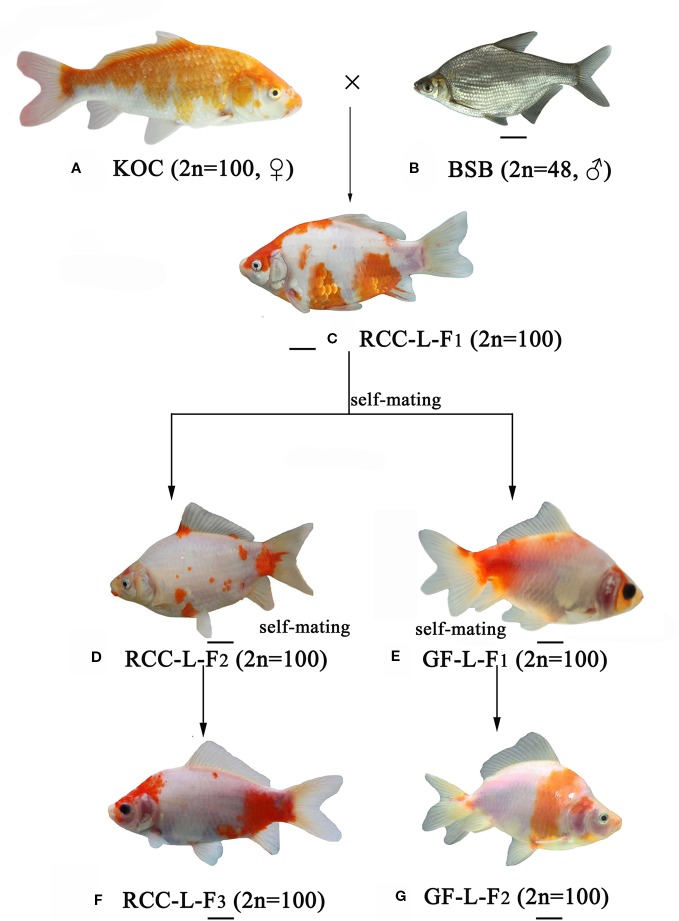
The formation of experimental ﬁsh hybrids. (A) KOC; (B) BSB; (C) RCC-L-F1; (D) RCC-L-F2; (E) GF-L-F1; (F) RCC-L-F3; (G) GF-L-F2, Bar = 3cm.